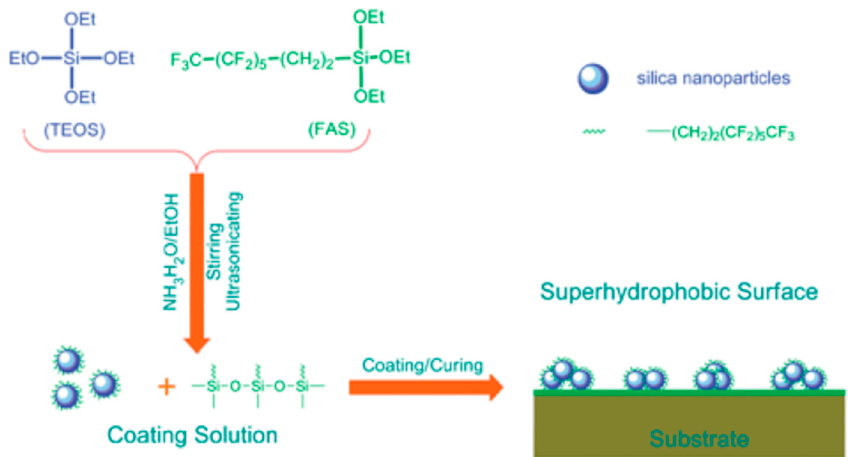
Figure 3. Schematic illustration of the synthesis of fluorinated silica NPs, and the corresponding coating formed. Reprinted with permission from [77], Copyright (2008) Royal Society of Chemistry.